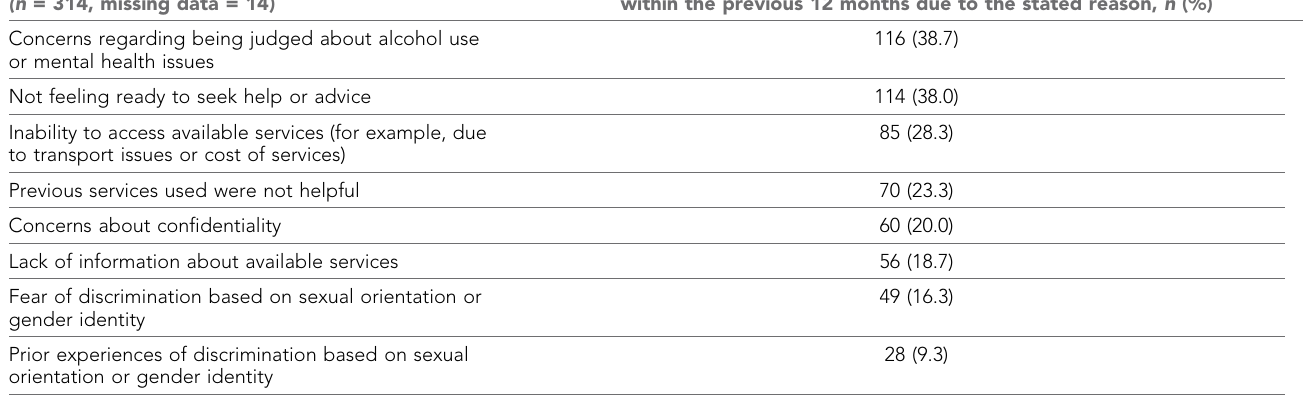
Table 4. Barriers to treatment utilisation for mental health and alcohol-related problems among those in need of services (based on high CES-D-10, AUDIT score, or suicide attempts within 12